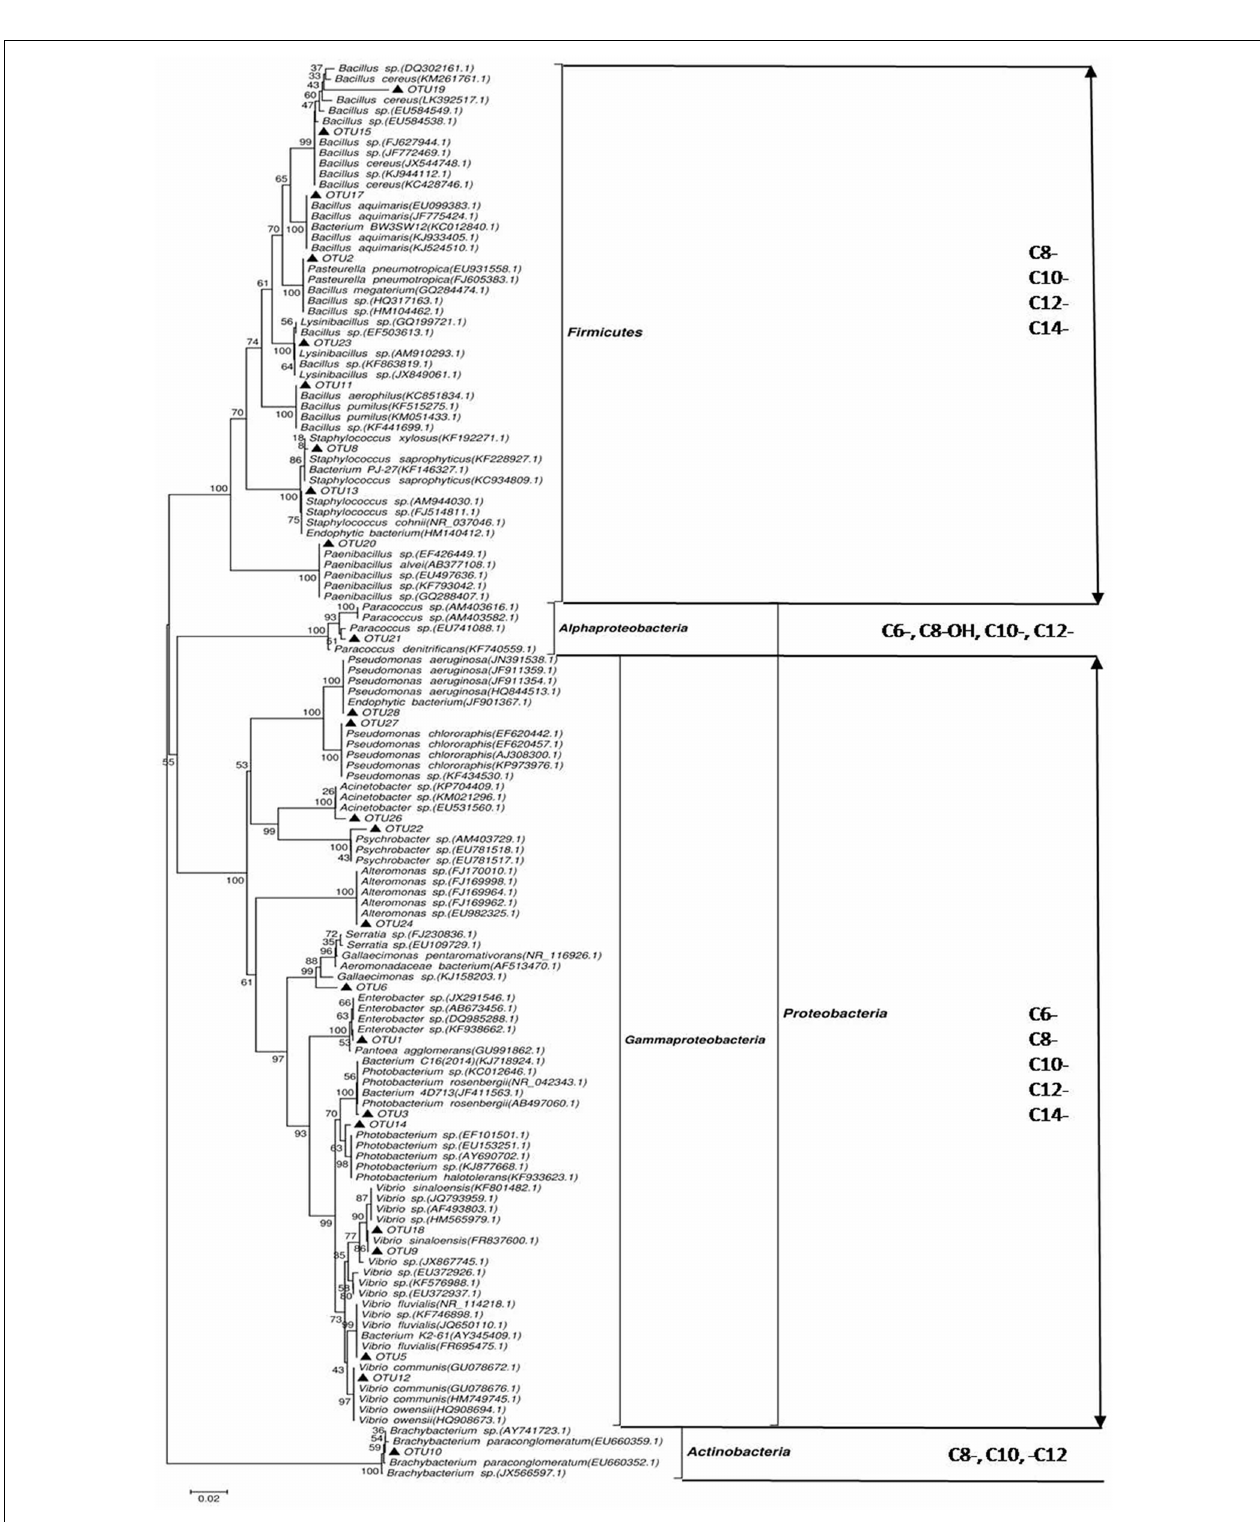
FIGURE 1 | Phylogenetic tree of N -acyl-homoserine lactone (AHL)-producing rhizobacteria based on neighbor joining clustering and species identification by 16S rRNA gene sequence alignment to the NCBI GenBank database. Phylum taxa appear on the right, with the external distribution made by class and the internal distribution made by genus. (cid:78) , isolates that induced AHL activity detected by the A136 indicator strain. Bootstrap probabilities are indicated at branch nodes (values under 50% were excluded). The bar represents three substitutions per 100 nucleotide positions. GenBank accession numbers deposited in the NCBI database are given for partial 16S rRNA sequences of all